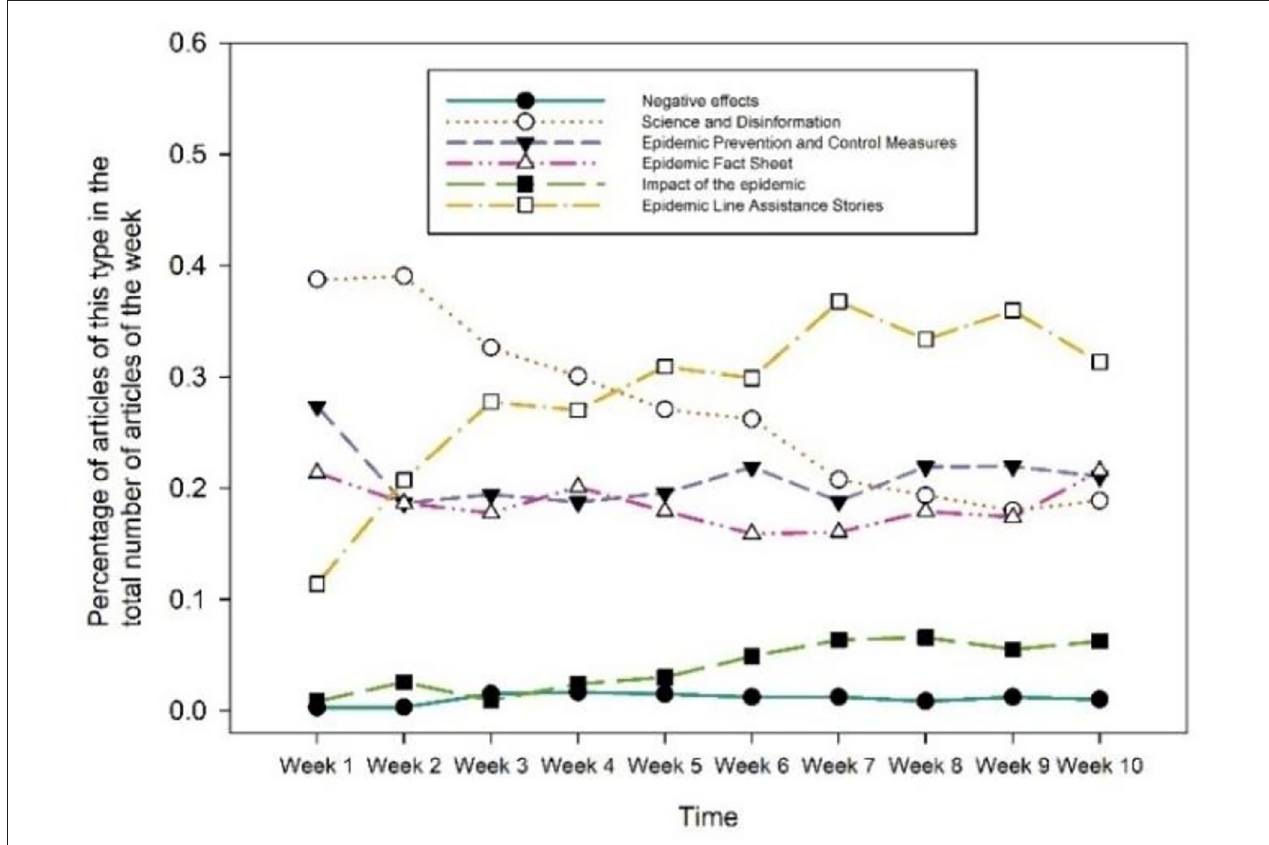
FIGURE 6 | Tweets with posting time by content